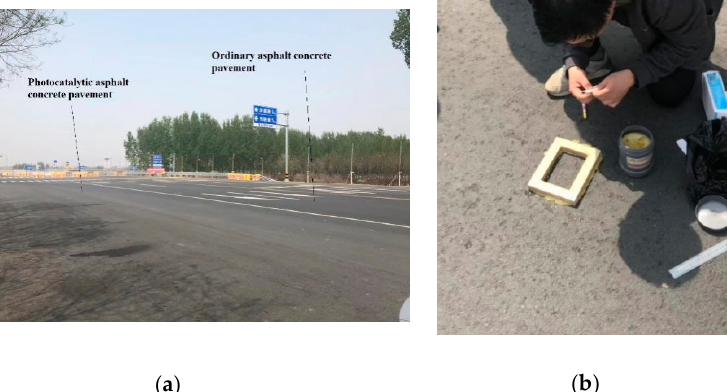
Figure 10. Outdoor nitrogen oxide collection experiment: ( a ) photocatalytic pavement and original pavement; ( b ) collecting water samples.